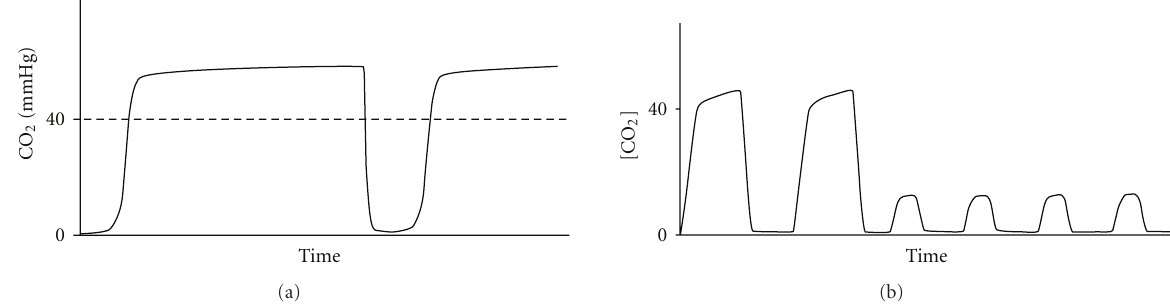
Figure 2: (a) Bradypneic Hypoventilation (type1). (b) Hypopneic Hypoventilation (type2).